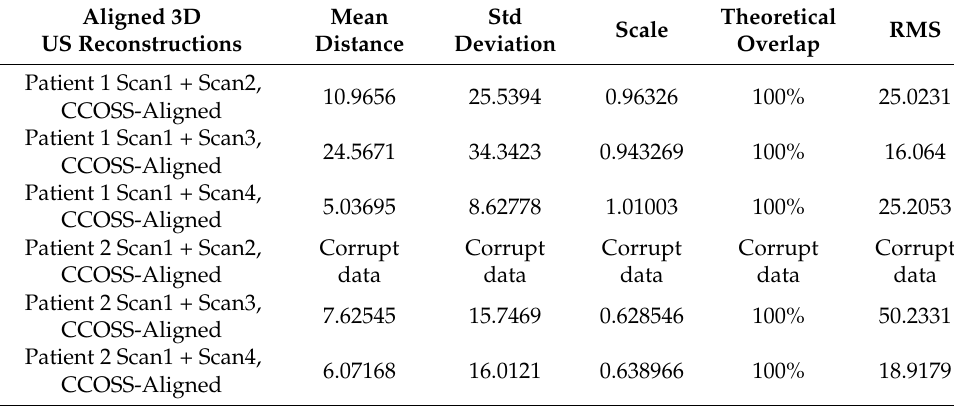
Figure 5. ( a ). The 3D US reconstruction of the carotid artery circulated lumen, ( a ′ ). the centroid of the cross-section of the circulated lumen, and ( a ″ ): representation in the 3D space of the centroids of the 2D ultrasonographic section through the carotid artery. ( b ). The CT angiography for the carotid artery of the circulated lumen, ( b ′ ). the transversal section through the carotid arteries’ CT scans, and ( b ″ ). extracted centroids of the carotid arteries, from the CT angiography represented in the 3D space. Table 4. Mean distances and stds for the aligned 3D US